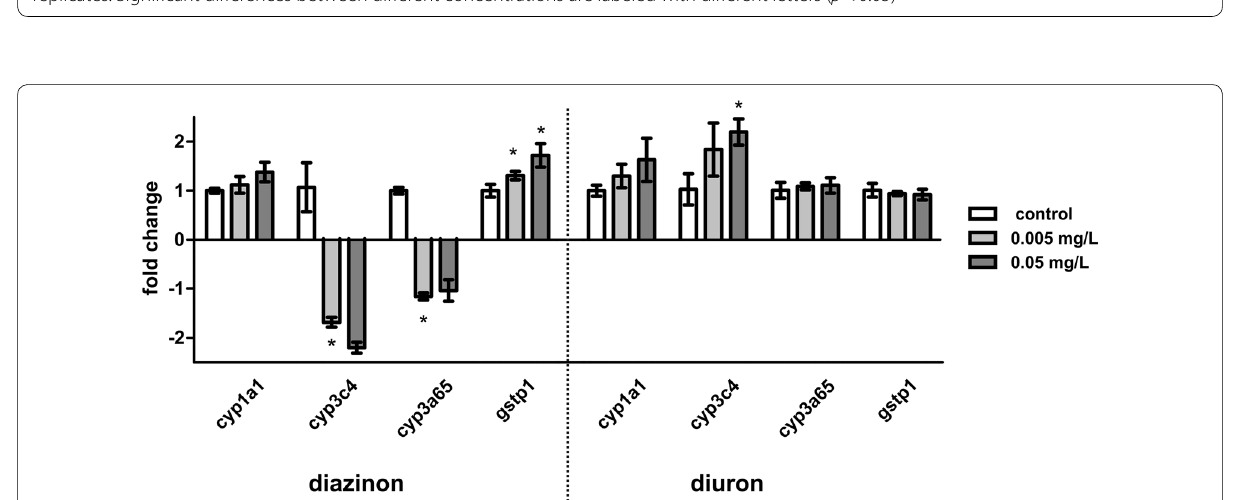
Fig. 7 Differential gene expression of several genes in zebrafish embryos (72 hpf) exposed for 48 h to diazinon and diuron. The expression was normalized with the housekeeping gene β‑actin. Bars represent means with standard deviation of three independent replicates. Significant differences are labeled with * p <